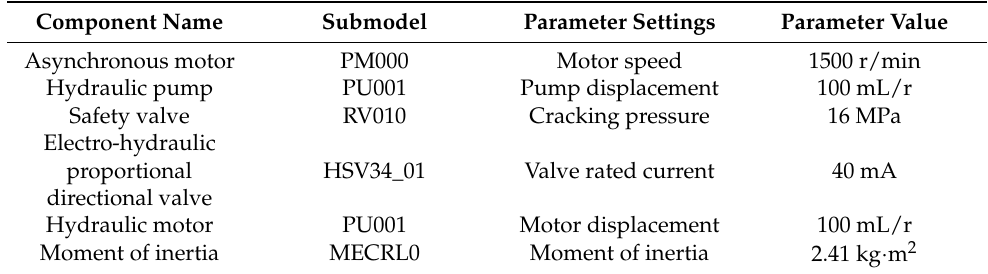
Table 1. Parameter settings of main components of the slewing rotary